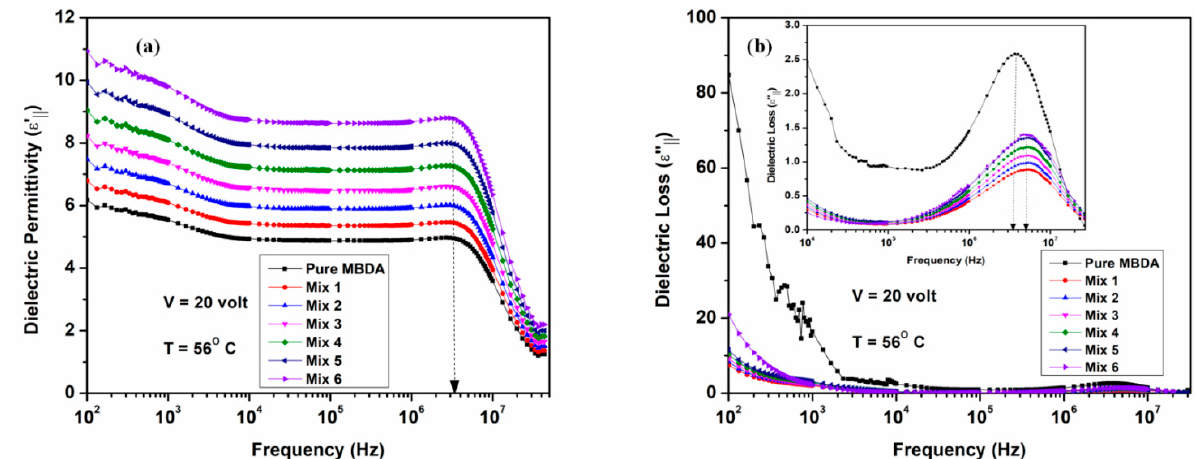
Figure 6. ( a ) Variation of dielectric permittivity versus frequency at 20 volt applied bias and 56 ◦ C temperature for pure nematic MBDA and its mixture with core/shell quantum dots (Mix 1 to Mix 6); ( b ) Variation of dielectric loss versus frequency at 20 volt applied bias and 56 ◦ C temperature for pure nematic MBDA and its mixture with core/shell quantum dots (Mix 1 to Mix 6).